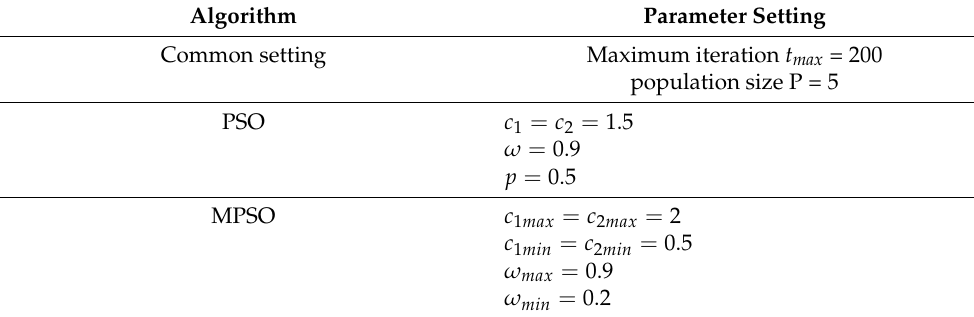
Table 2. Parameter value of PSO and MPSO.